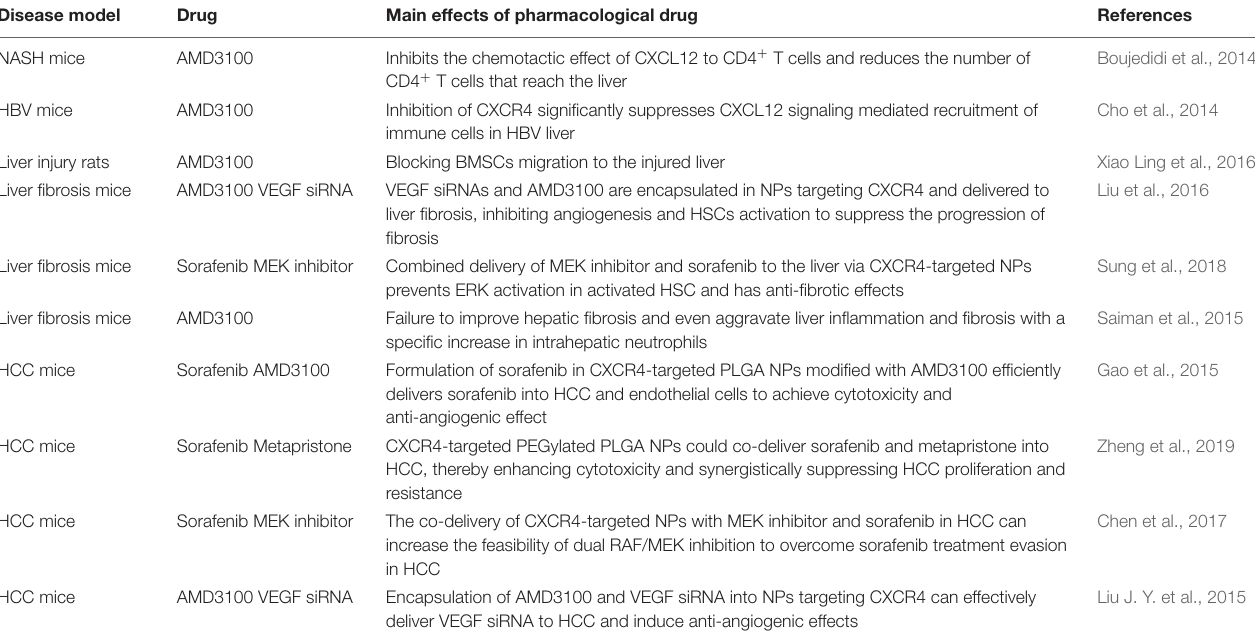
TABLE 2 | Summary of drug studies targeting CXCR4 and its ligand in animal models of liver